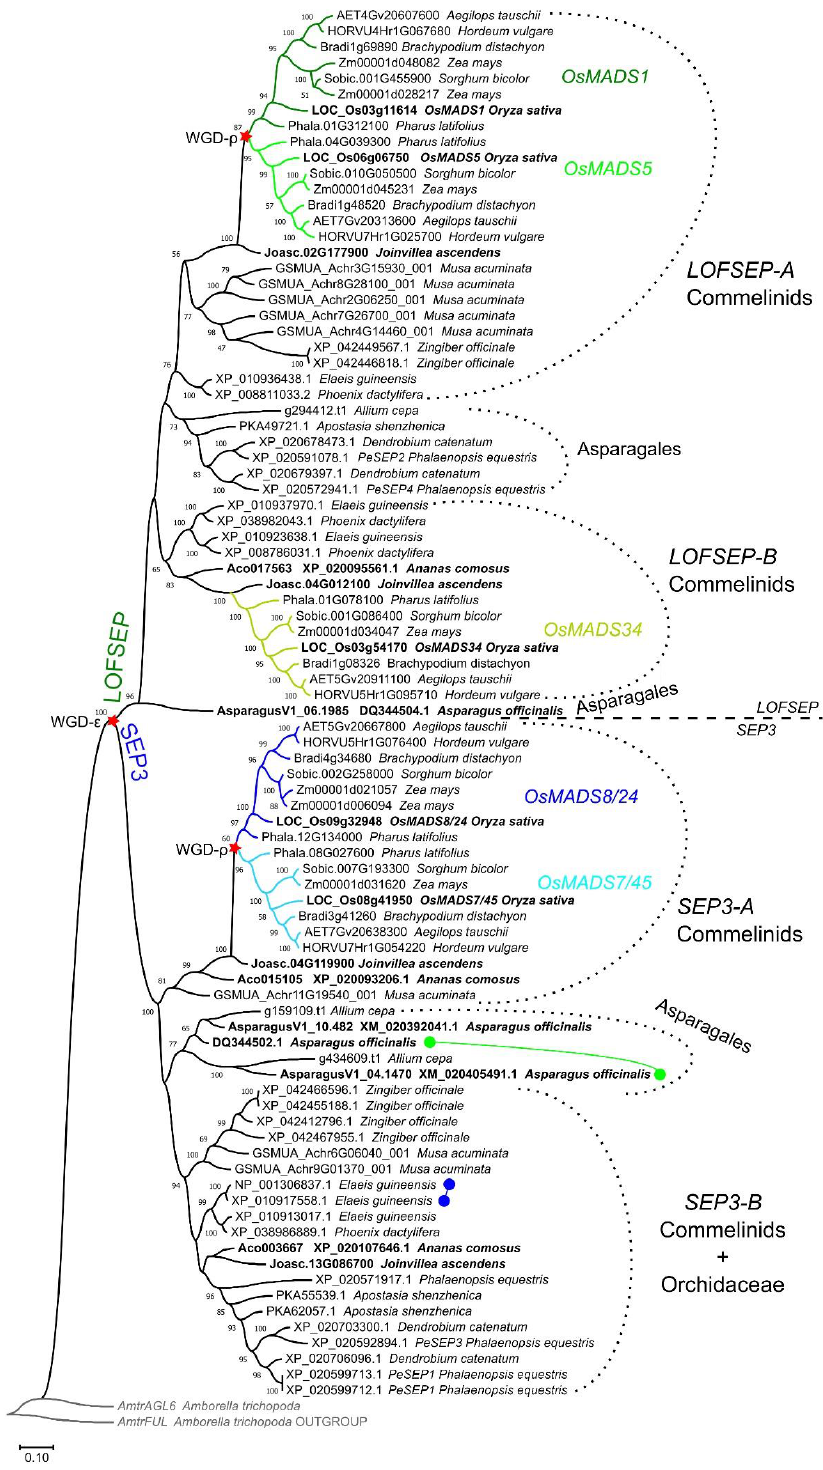
Figure 1. ML phylogenetic analysis of the SEPALLATA ( SEP ) subfamily genes from the core monocots commelinids and Asparagales. Dichotomies unequivocally linked to the angiosperm WGD- ε and the grass WGD- ρ events are marked with a red star. The three LOFSEP subclades of grasses, OsMADS1 , OsMADS5 and OsMADS34 , are marked with different shades of green. The two SEP3 subclades of grasses, OsMADS7/45 and OsMADS8/24 , are marked with different shades of blue. Two tandem duplication events of SEP3 genes were detected in Asparagus officinalis and in Elaeis guineensis , which are marked with green and blue connected circles,